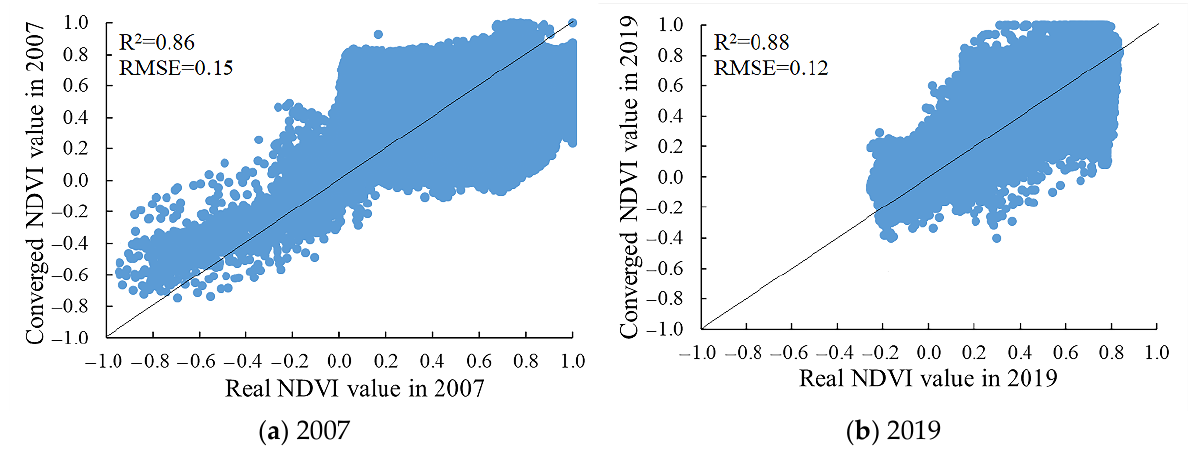
Figure 3. Distribution of 5 typical image subsets.